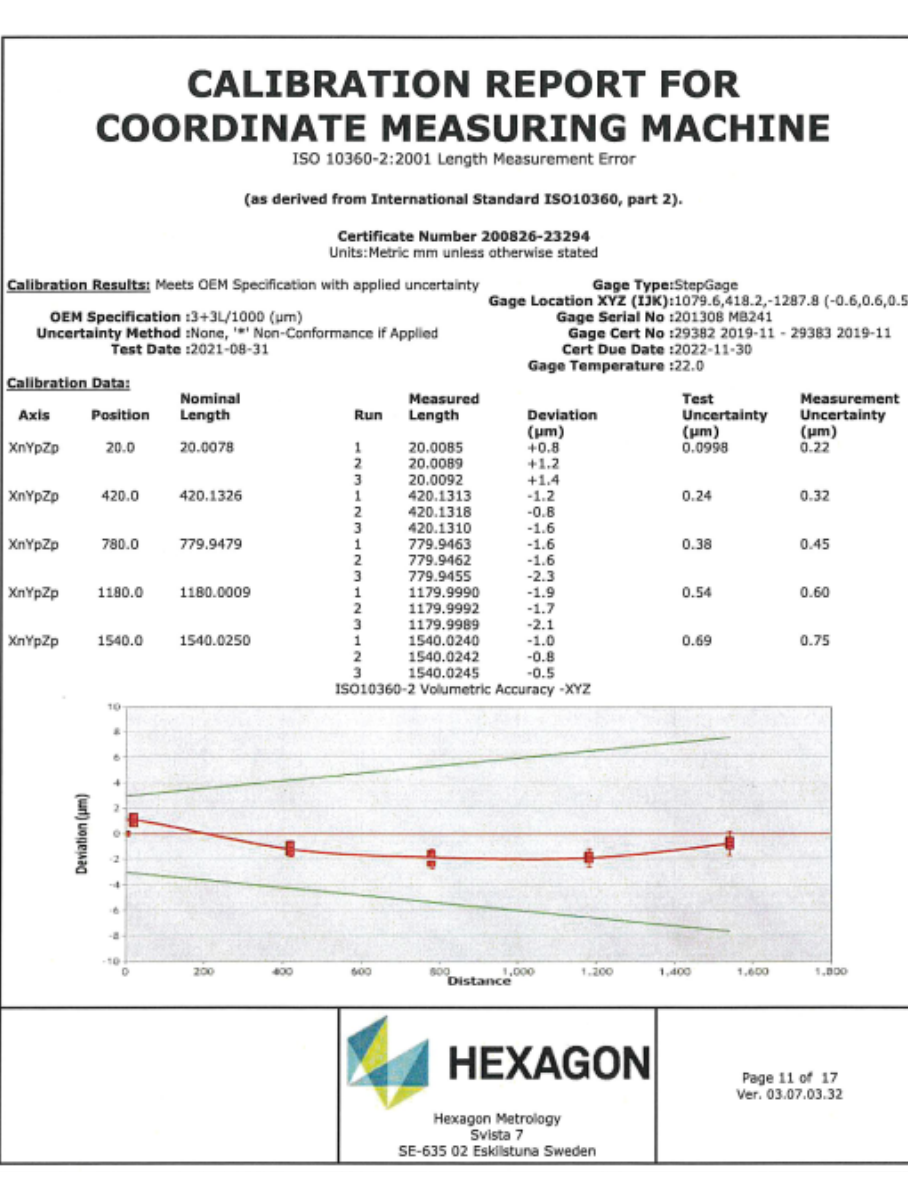
Figure 12. Verification and periodic inspection of manufactured MPQP test artefacts in a dedicated Saab calibrated and traceable reference CMM machine.